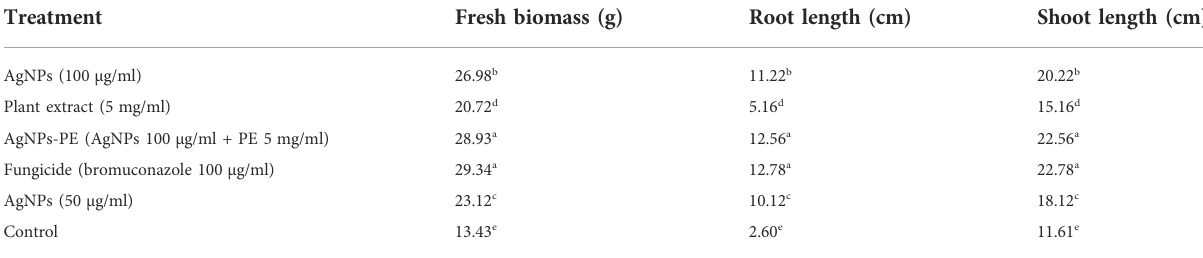
TABLE 4 Effect of different treatments on the growth parameters of tomato during in planta experiment against F. oxysporum. Different letters are showing statistical differences among treatments at p < 0.05 after performing Tukey HSD test.